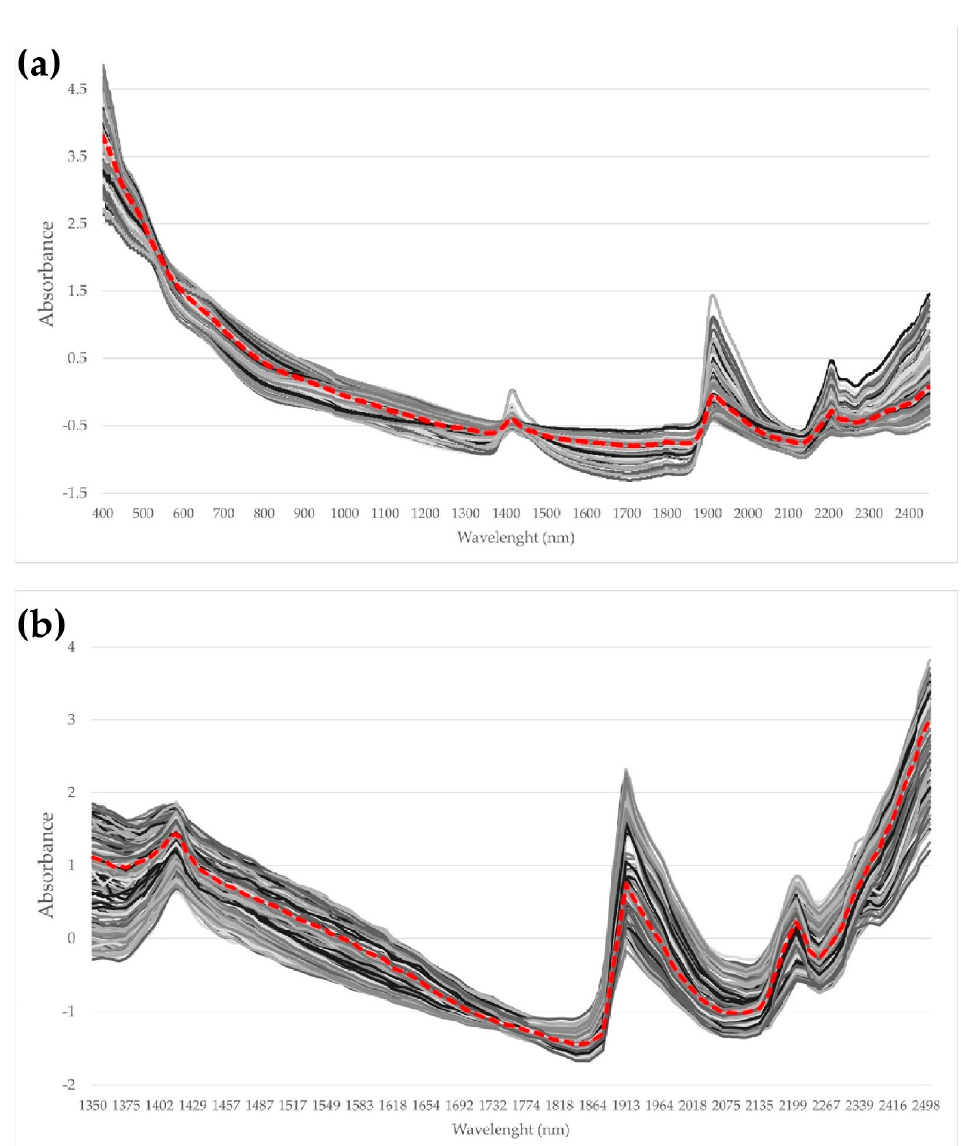
Figure 4. Spectra graphs obtained by ASD-Fieldspec ( a ) and Neospectra Scanner ( b ). The red dashed line represents the median of the spectra.